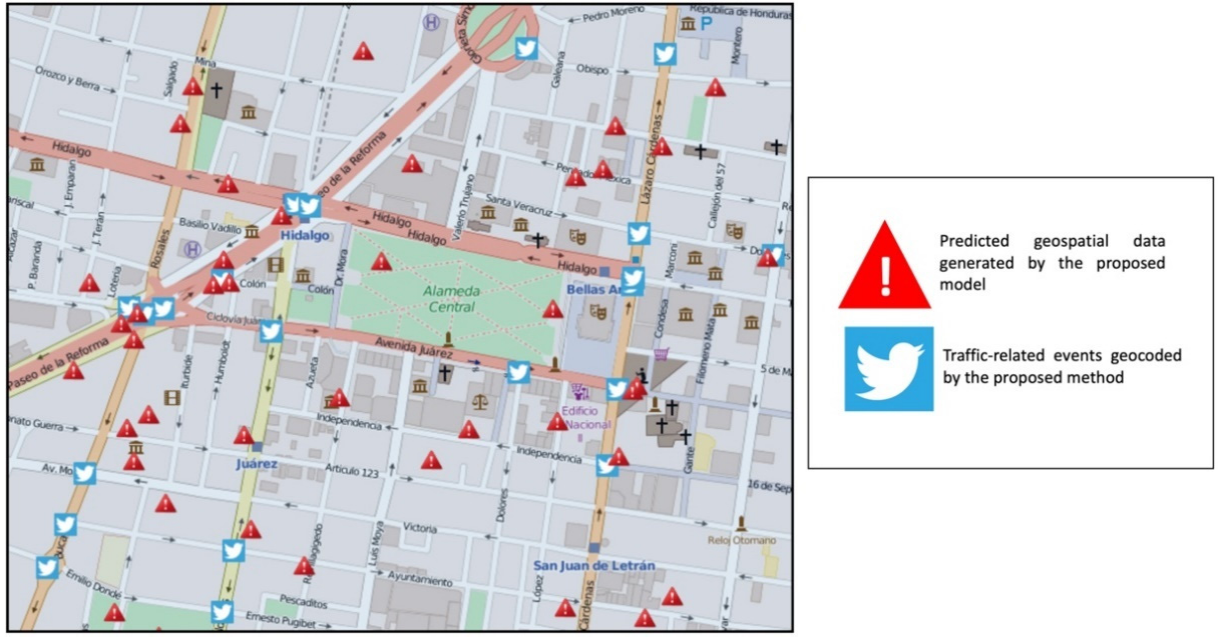
Figure 6. Comparison between predicted and geocoded traffic ‐ related events.